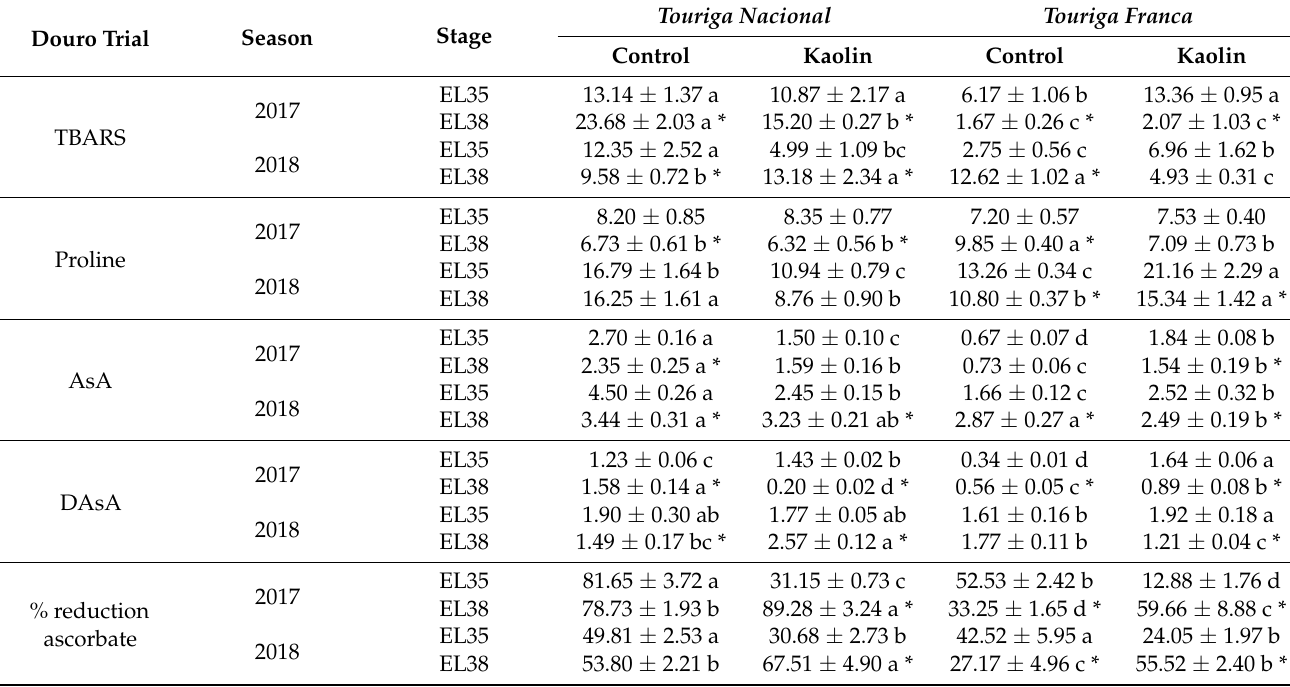
Data are mean ± SD ( n = 6). Different lower case letters represent significant differences between treatments and varieties within each developmental stage (EL35 and EL38), and sampling year. The asterisks (*) indicate significant differences ( p < 0.05) between developmental stages (EL35 vs. EL38) within each variety, treatment, and sampling